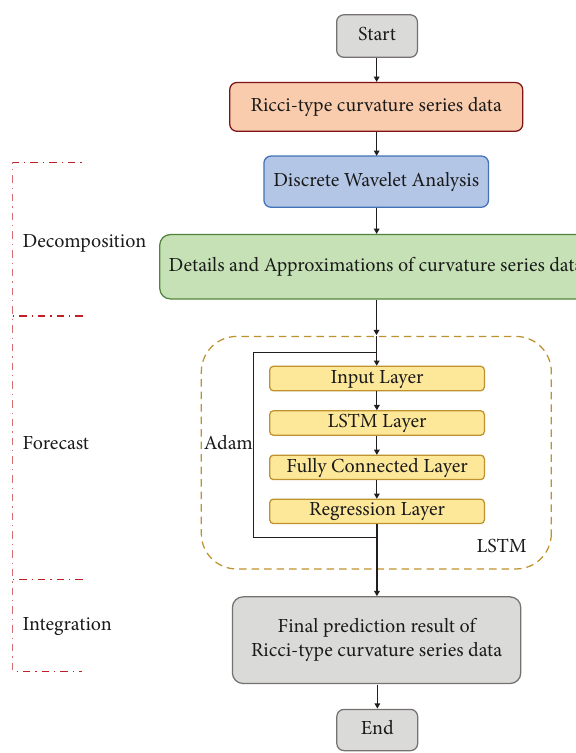
Figure 1: Te architecture of